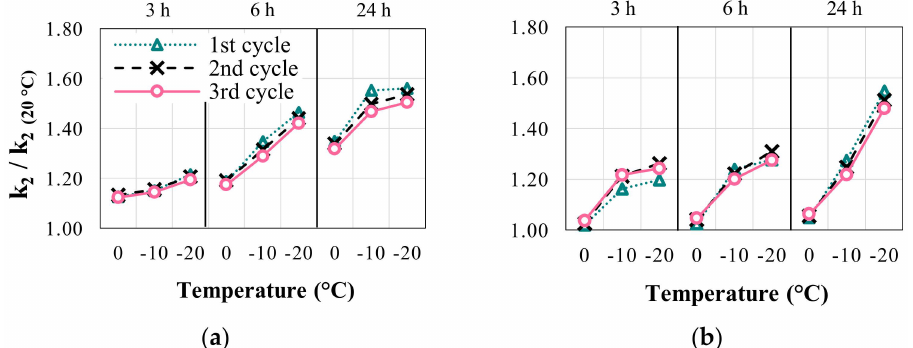
Figure 14. Comparison of normalized post-yield stiffness for 0.5 Hz loading frequency at ( a ) 100% and ( b ) 134% shear